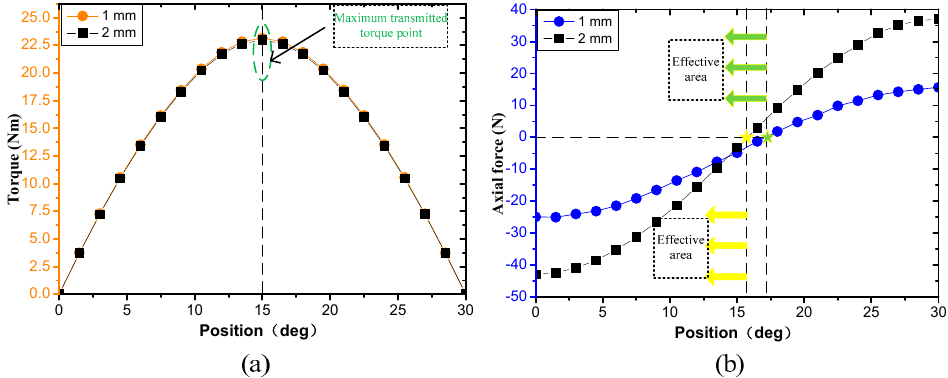
Figure 10. Influence of different axial displacements. ( a ) Torque and ( b ) Axial force.